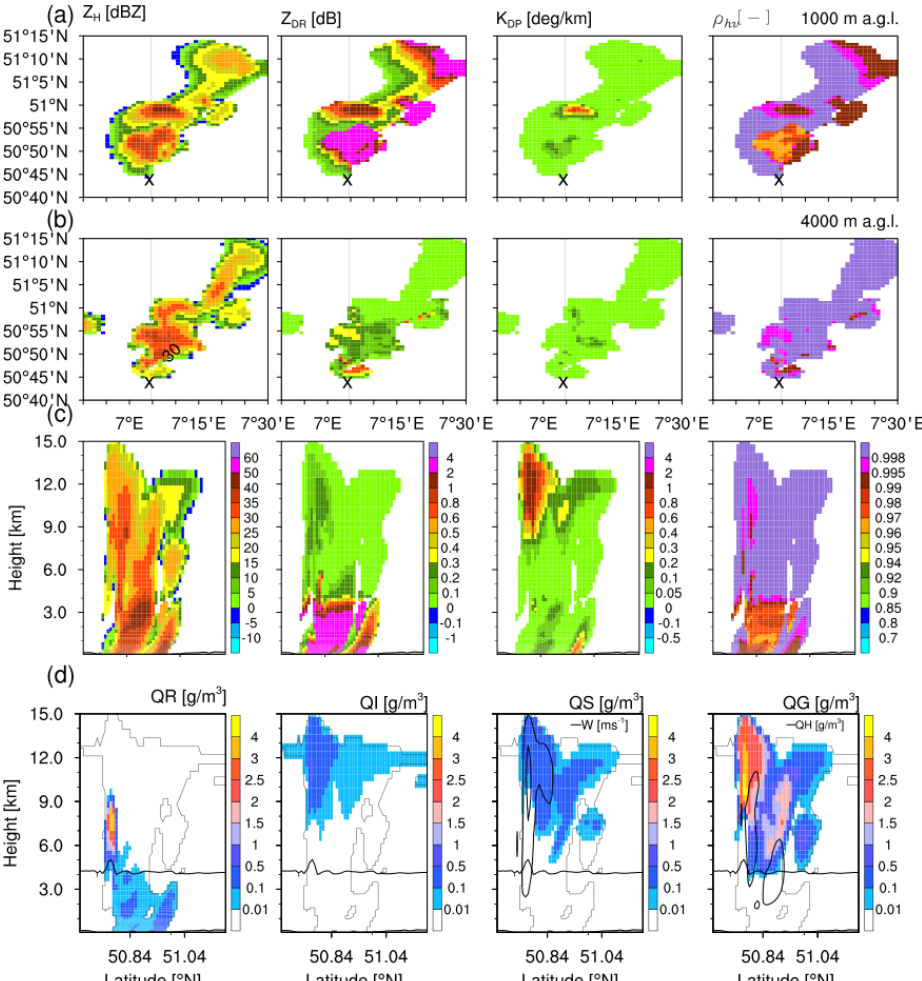
Figure 6. (a, b) Model-simulated horizontal reflectivity, differential reflectivity, specific differential phase and cross-correlation coefficient at low level (1000ma.g.l.) and near the melting layer (4000ma.g.l.) on 5 July 2015 at 14:55UTC. The “ × ” symbol refers to the BoXPol location. The solid grey line indicates the location of cross section. (c) Cross section of the same polarimetric variables. (d) Cross section of model-simulated hydrometeor density – Q R (rain), Q I (ice), Q S (snow), Q G (graupel) and Q H (hail). Also shown are the 0 ◦ C line (solid black line) indicating the melting layer, contours of vertical velocity [5, 40ms − 1 ] with Q S and contours of the Q H with Q